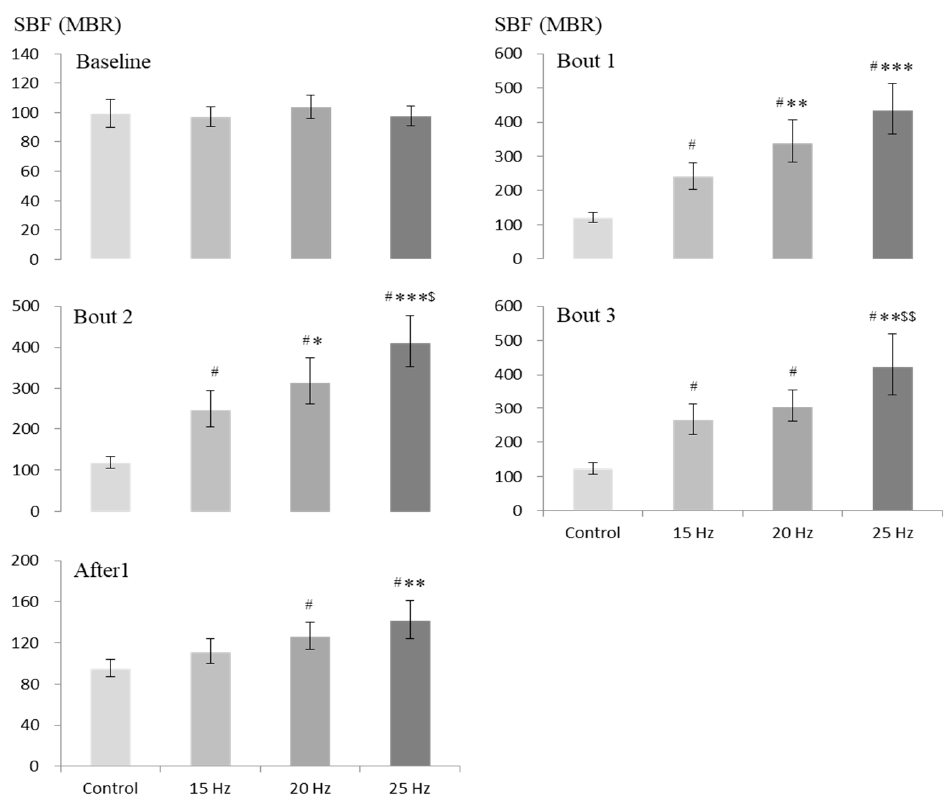
Figure 2. Comparison of SBF (MBR) between 4 exposure conditions at baseline (before), during (bouts 1, 2 and 3), and after exposure (n = 30). Values are shown as geometric mean and 95% CI (shown as error bars). Levels of significant differences from the corresponding values by repeated measures ANOVA with adjustments for multiple comparisons by Bonferroni corrections: # p < 0.001 versus control; *** p < 0.001, ** p < 0.005 and * p < 0.05 versus 15 Hz; $$ p < 0.01 and $ p < 0.05 versus 20 Hz.